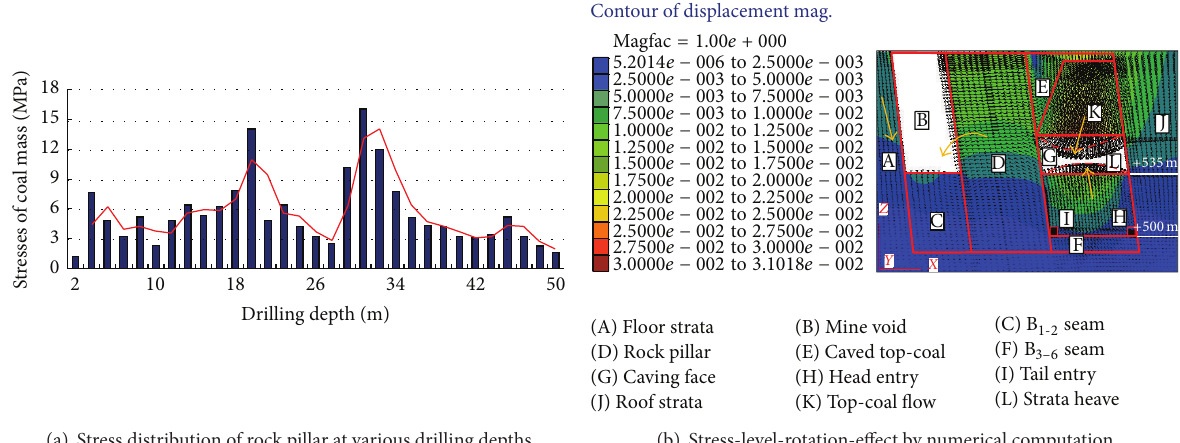
Figure 4: Relation between depths stress (a) and deformation distribution